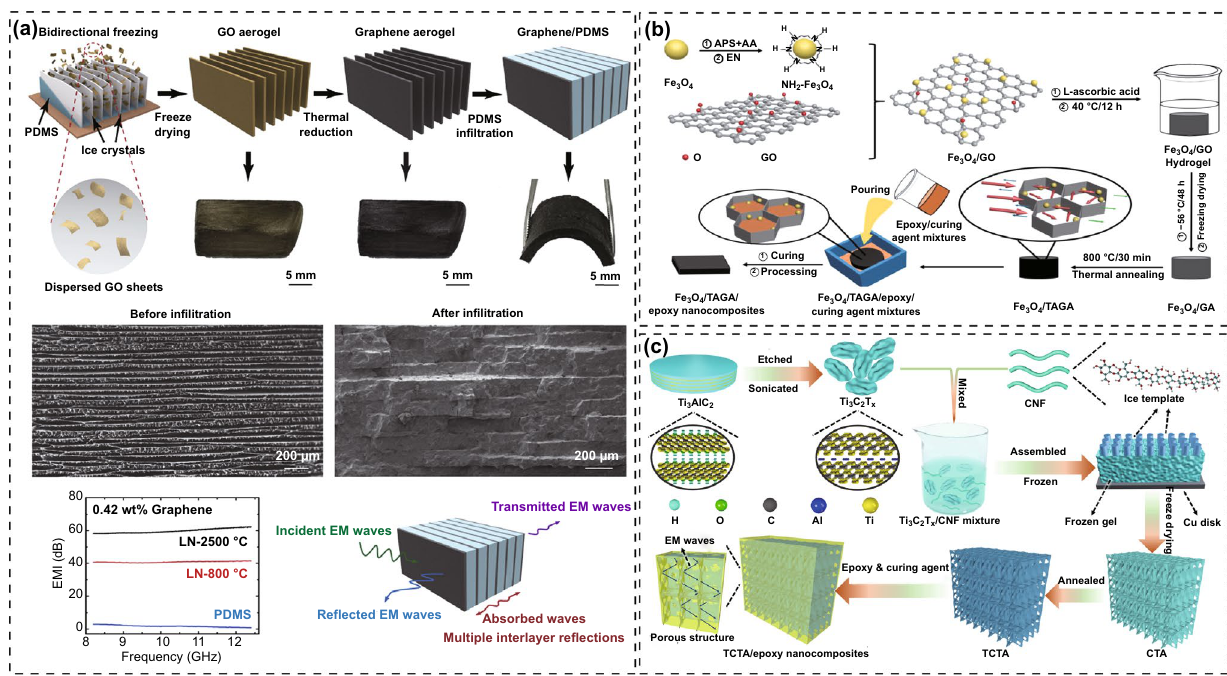
Fig. 14 Schematic illustrating the fabrication, SEM images and EMI SE of a graphene/PDMS, b Fe 3 O 4 /TAGA/epoxy, and c TCTA/epoxy com- posites [146, 149, 150]. Copyright © 2019 Elsevier. Copyright © 2018